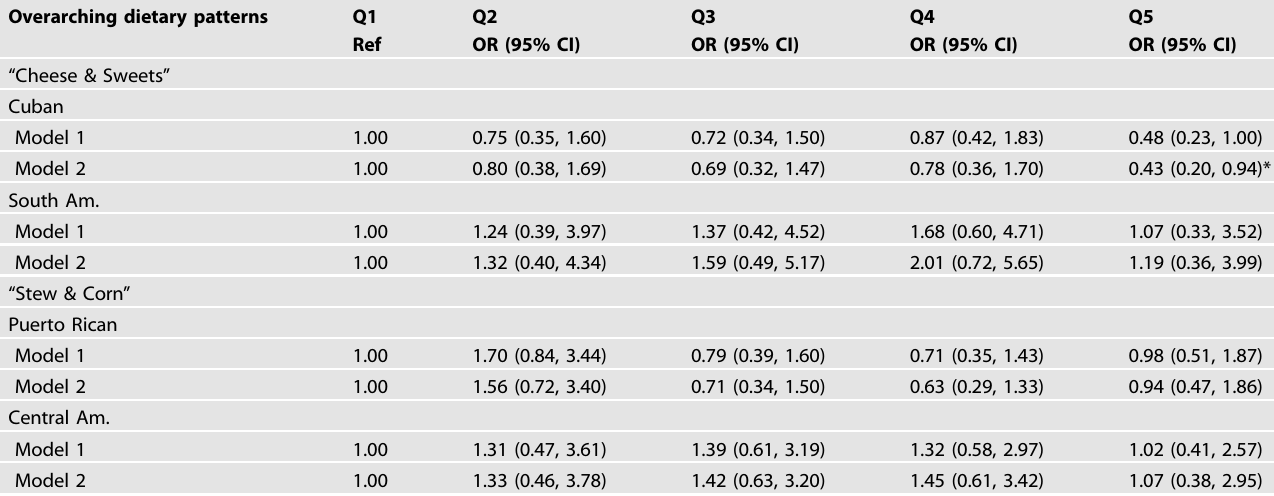
fi ndings is fi rst needed before formulating heritage-speci fi c dietary guidance. Second, since DPs were derived focusing on cultural and behavioral over nutrient value, ingredients/foods with contrasting effects on diabetes outcomes (e.g., white rice and beans) may have biased estimates towards the null. Future